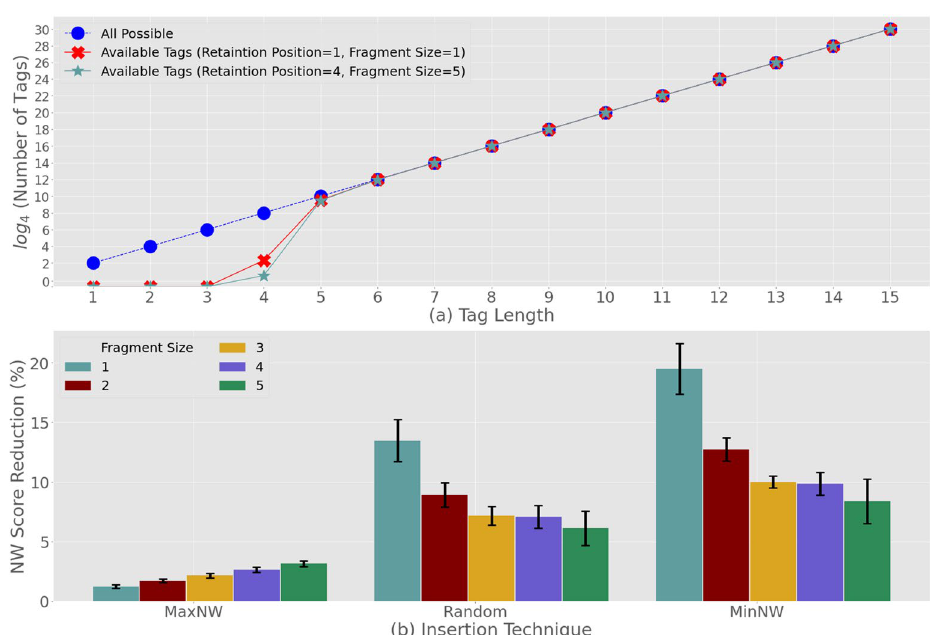
Figure 5. Trigger Sample Design with the use of DNA-Steganography: ( a ) nucleotide tag selection; ( b ) the impact of